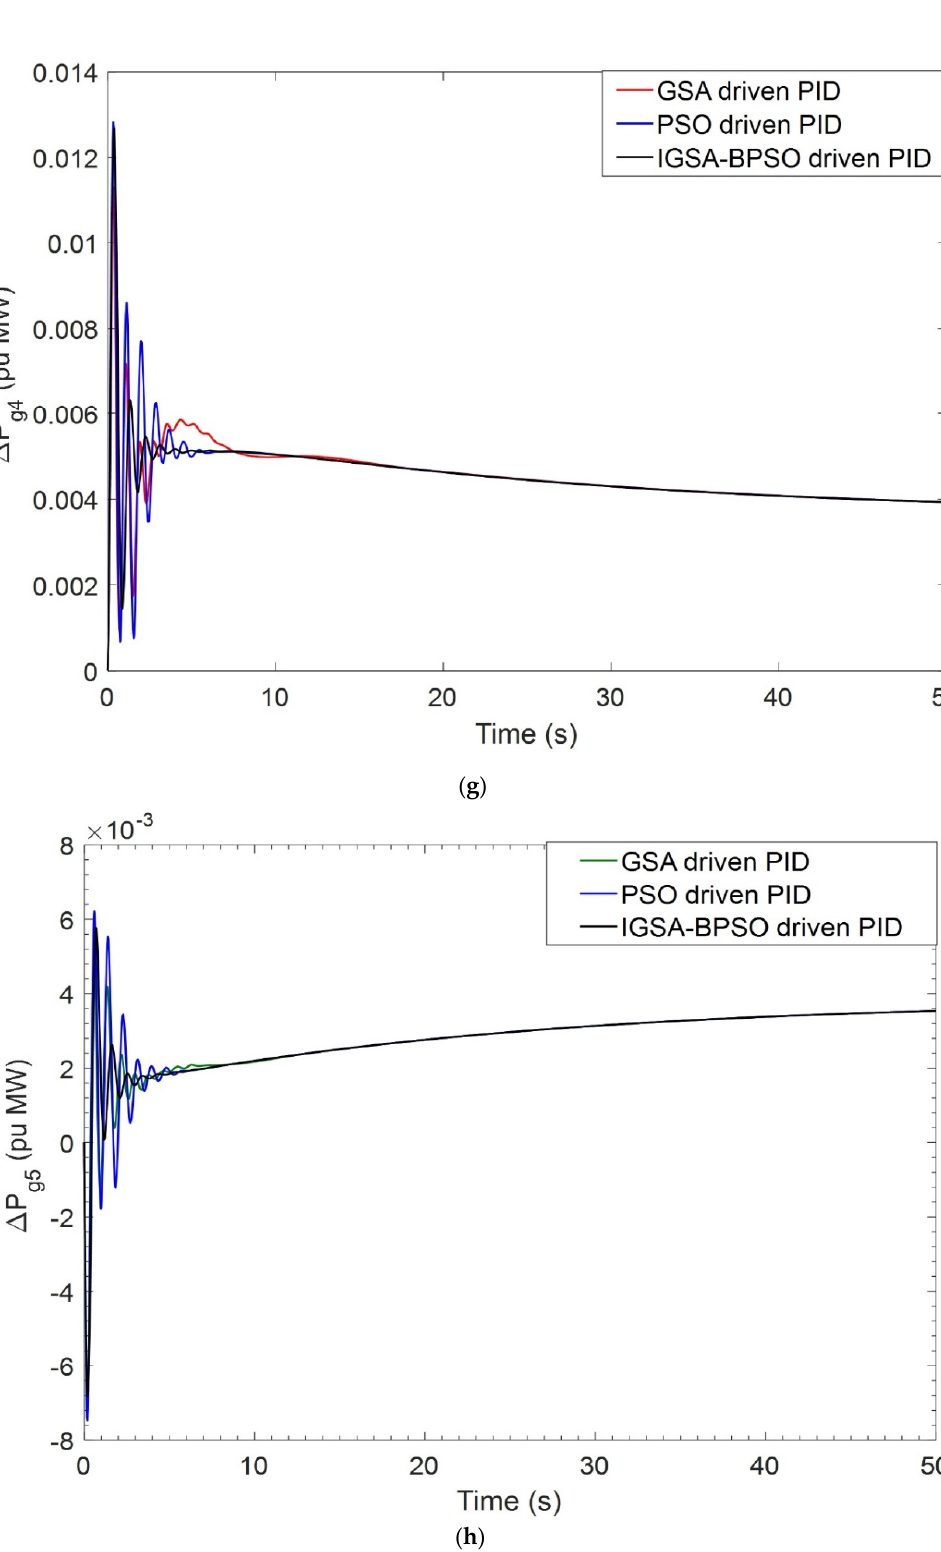
( i ) Figure 6. ( a ) Dynamic response of Δ F 1 for BBT case; ( b ) dynamic response of Δ F 2 for BBT case; ( c ) dynamic response of Δ P tie for BBT case; ( d ) perturbation response of GENCO–1 for BBT case; ( e ) perturbation response of GENCO–2 for BBT case; ( f ) perturbation response of GENCO–3 for BBT case; ( g ) perturbation response of GENCO-4 for BBT case; ( h ) perturbation response of GENCO-5 for BBT case; ( i ) perturbation response of GENCO-6 for BBT case.